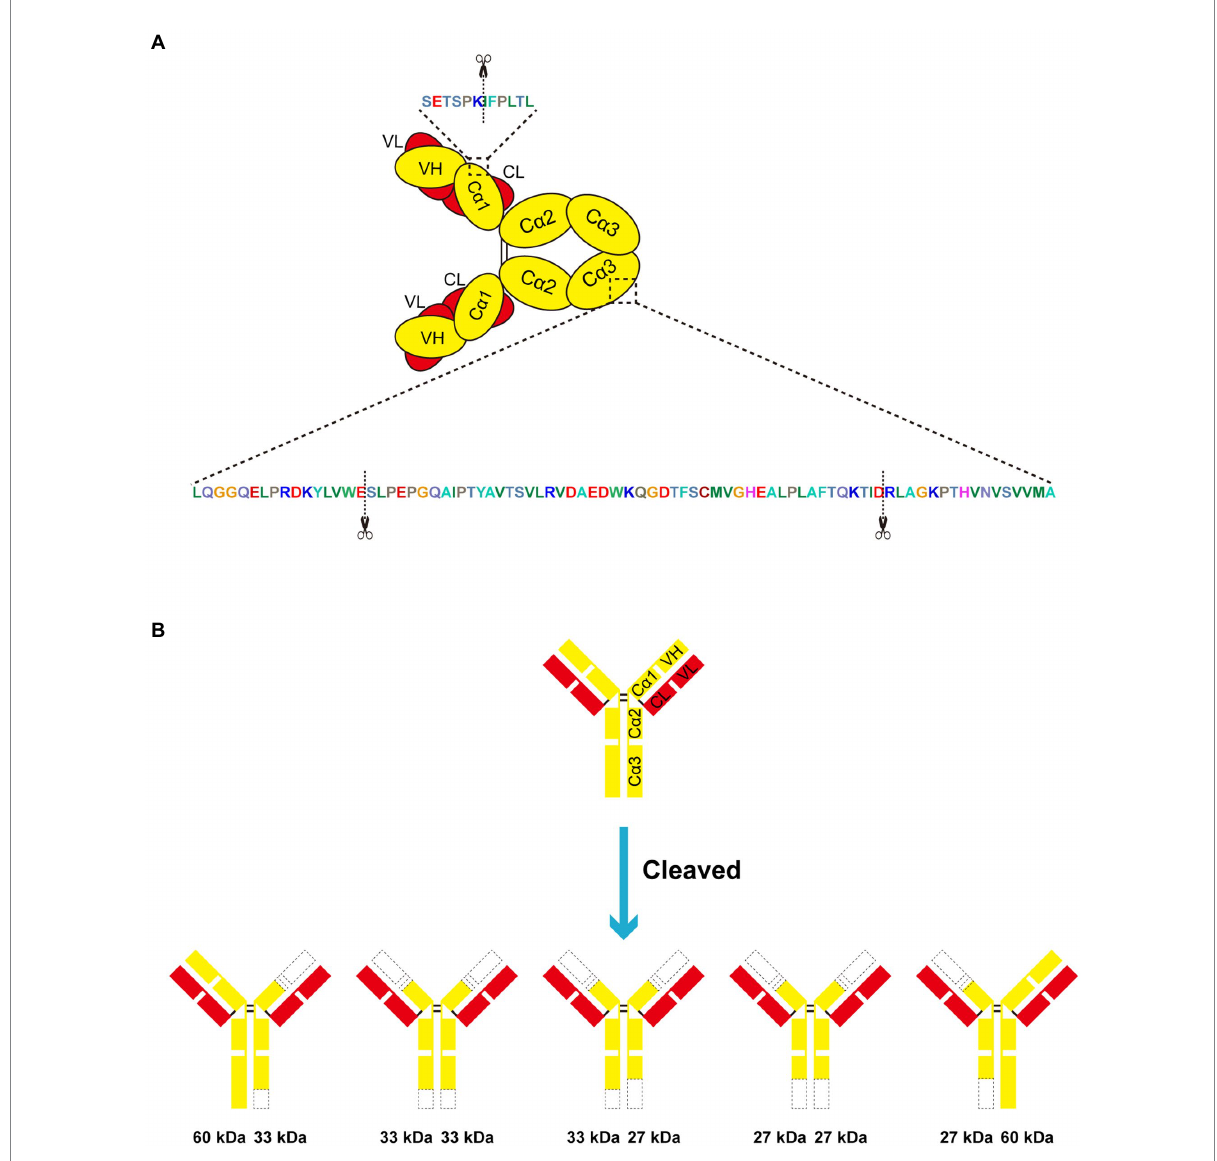
FIGURE 4 Swine lgA is cleaved within the Cd1 and Cu3 domain. (A,B) EspP1 and EspP2 have three different cleavage sites in swine IgA, which led to two different cleavage products with the molecular weight of ~33 and ~27 kDa under reducing condition. The cleavage sites are indicated with